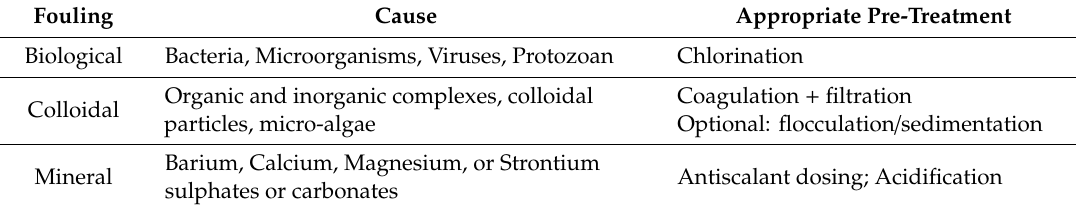
Cause Appropriate Pre-Treatment Biological Bacteria, Microorganisms, Viruses, Protozoan Chlorination Organic and inorganic complexes, colloidal Coagulation + filtration Colloidal particles, micro-algae Optional: flocculation / sedimentation Barium, Calcium, Magnesium, or Strontium Antiscalant dosing; Mineral sulphates or carbonates